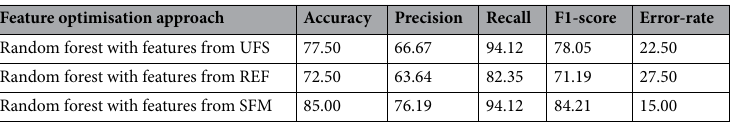
Table 2. The performance of the random forest algorithm from the testing phase using three different attribute/feature optimisation approaches. Values are in percentage.